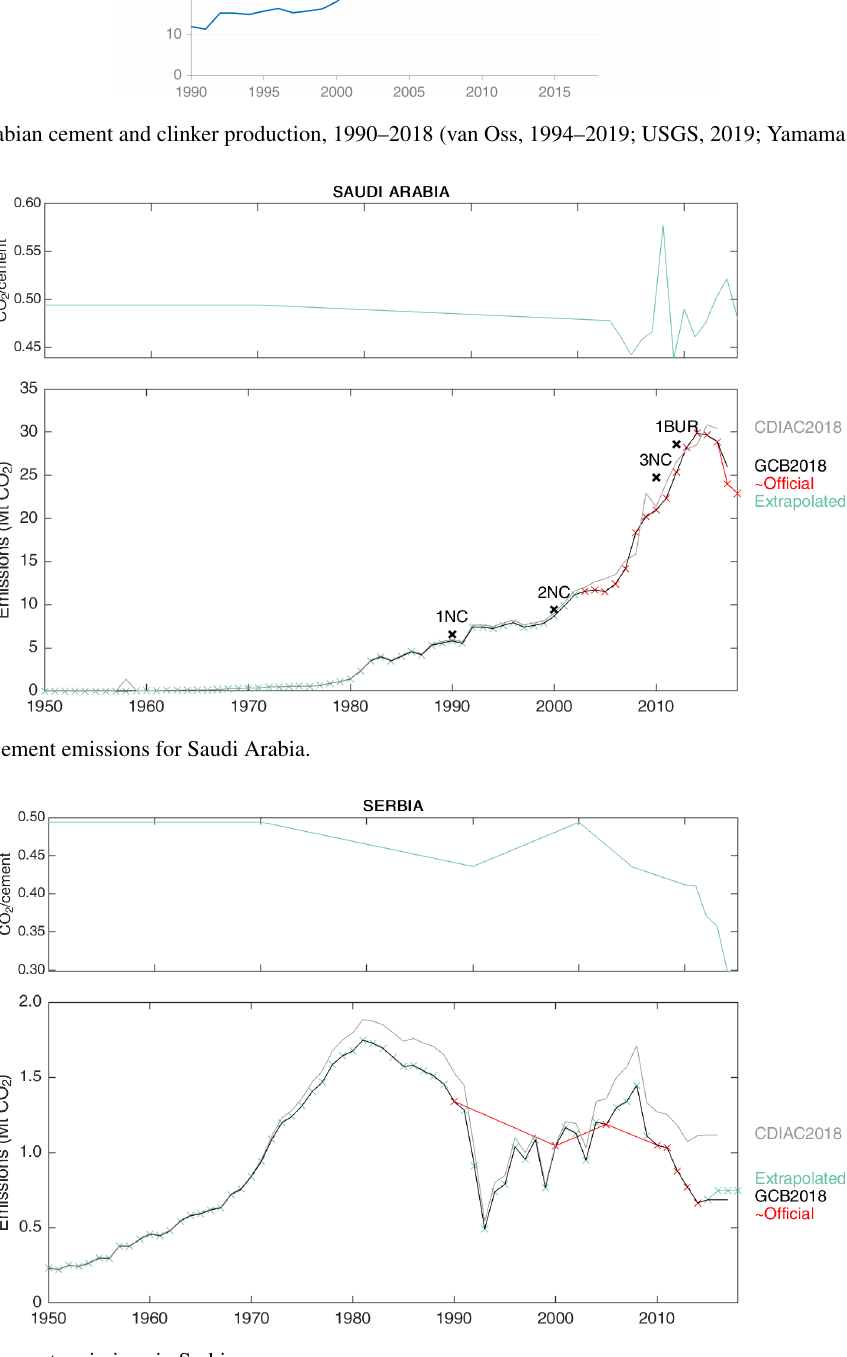
Figure C39. Revised cement emissions in